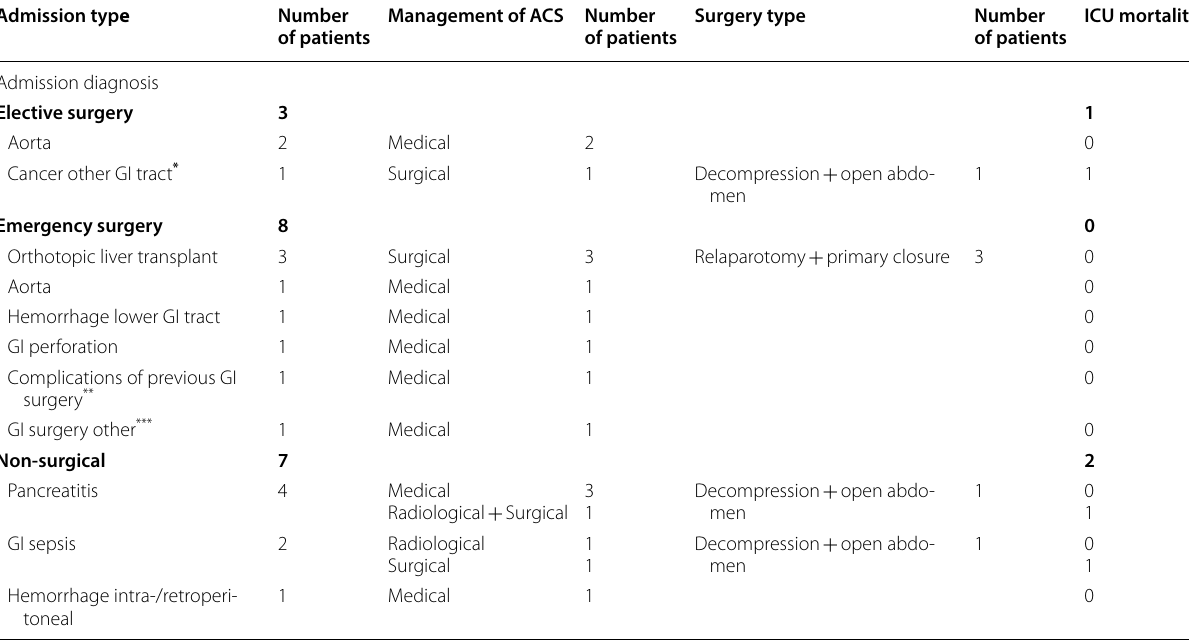
18) by admission type =